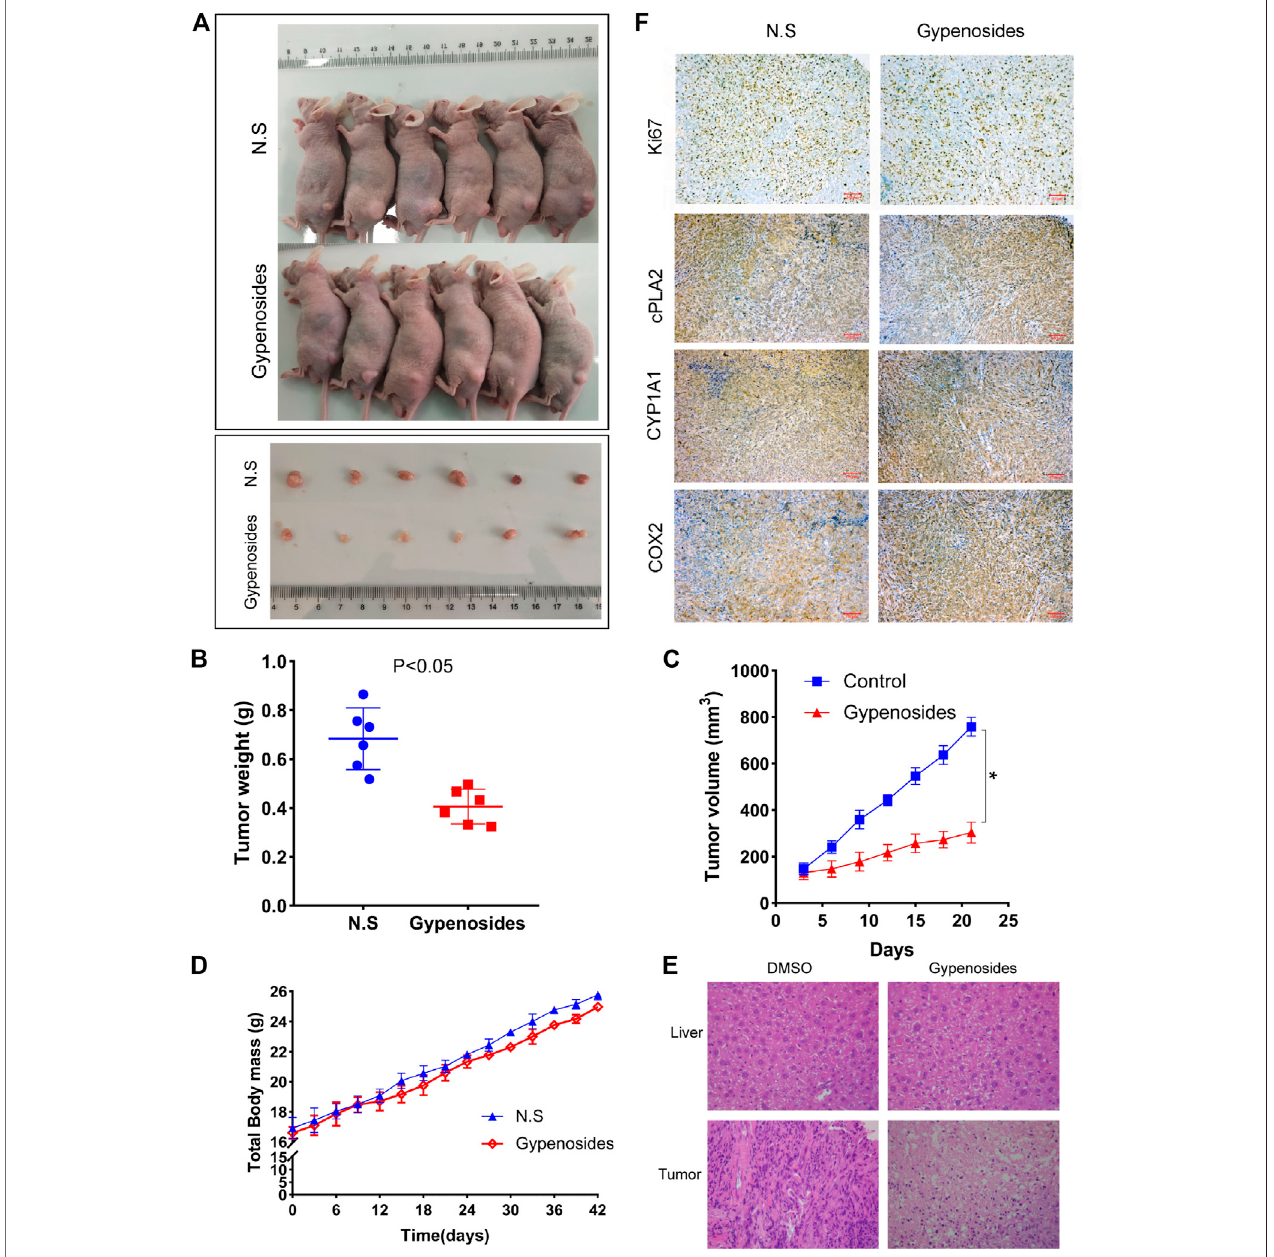
FIGURE 6 | Gypenosides suppressed the growth of RCC cell xenograft tumors in vivo . (A) Nude mice were treated with saline or gypenosides for 28 days, and picturesofnudemice and tumors wereobtained. (B) Changesin tumor weight aftergypenosideadministration, compared withthecontrolgroup. (C) Changesintumor volume after administration of gypenosides, compared with the control group. (D) The body weight of the two groups of mice during the entire experiment. (E) HE staining of mice liver and tumors. (F) The differences in the protein expression levels of Ki67, cPLA2, CYP1A1, and COX2 between the two tumor groups were detected by